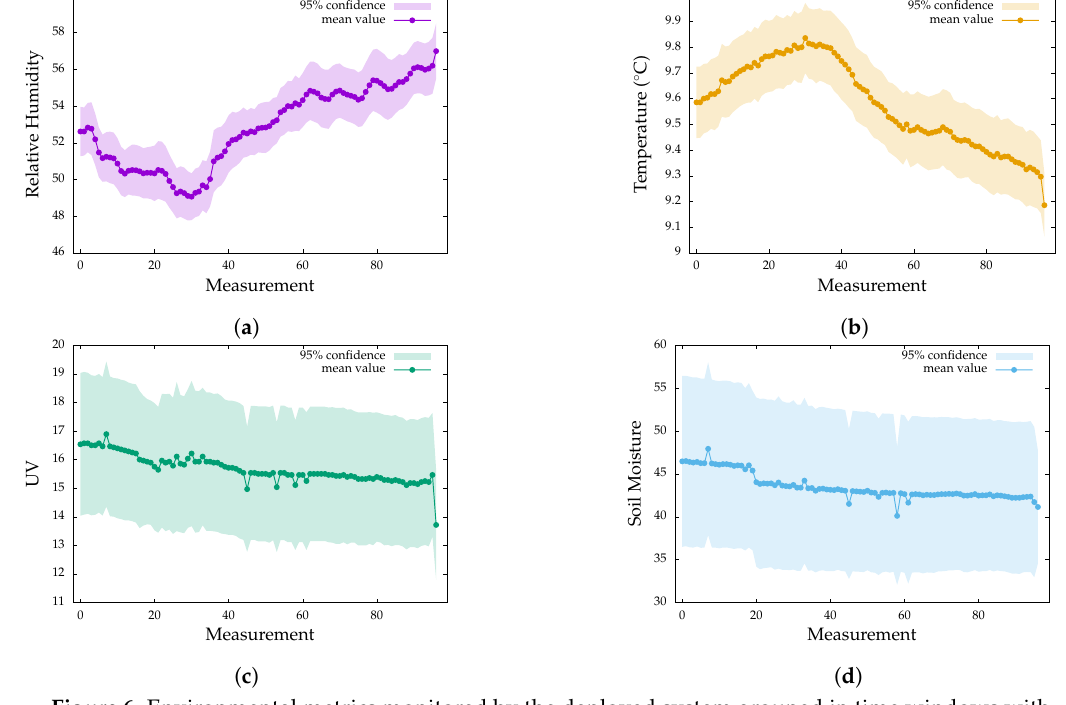
Figure 6. Environmental metrics monitored by the deployed system grouped in time windows with respect to time: ( a ) relative humidity levels; ( b ) temperature in degrees Celsius; ( c ) UV radiation; and ( d ) soil moisture mapped to [0, 100] range, with higher values indicating higher levels of